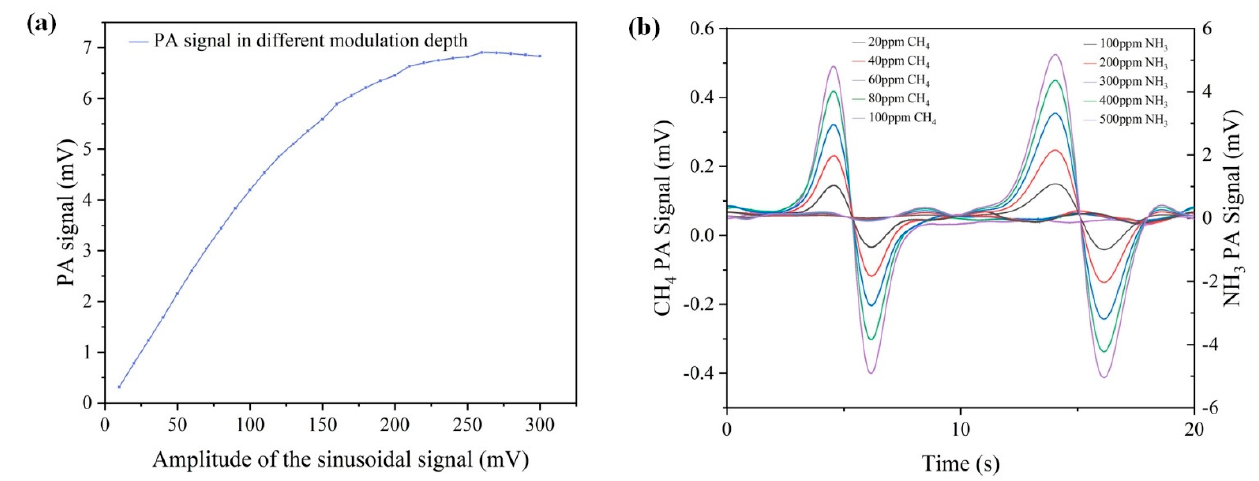
Figure 5. ( a ) PA signals of different amplitudes of the sinusoidal signal. ( b ) First harmonic PA signals of CH 4 concentrations varying from 20 to 100 ppm in the left region and NH 3 concentrations varying from 100 to 500 ppm in the right region.